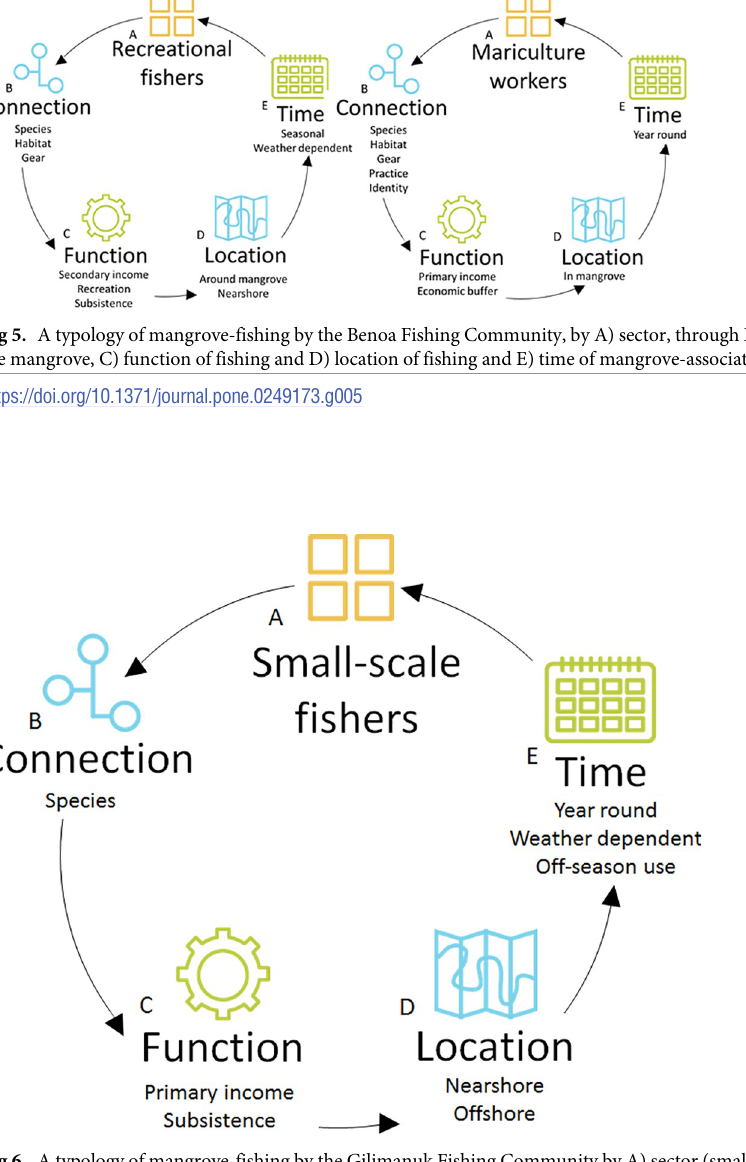
Fig 6. A typology of mangrove-fishing by the Gilimanuk Fishing Community by A) sector (small scale fishers only) through B) connection with the mangrove, C) function of fishing and D) location of fishing and E) time of mangrove- associated of fishing.